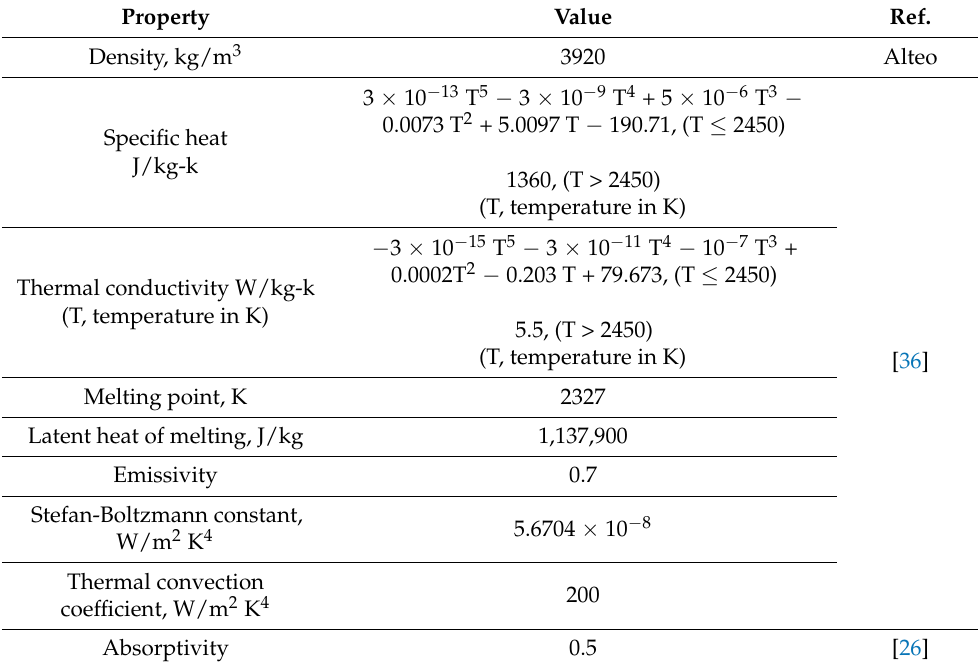
Table 1. Physical and thermal properties of alumina feedstock.